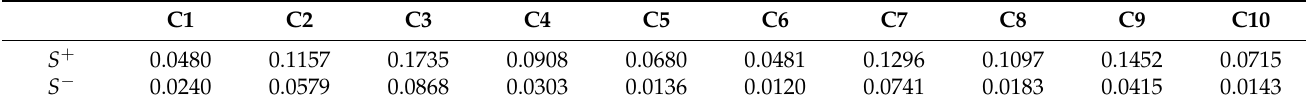
Table 5. The ideal solution and anti-ideal solution of each index.